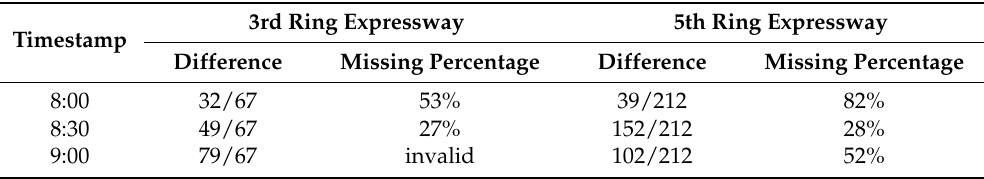
Table 2. Situations of missing traffic data during peak timestamps.